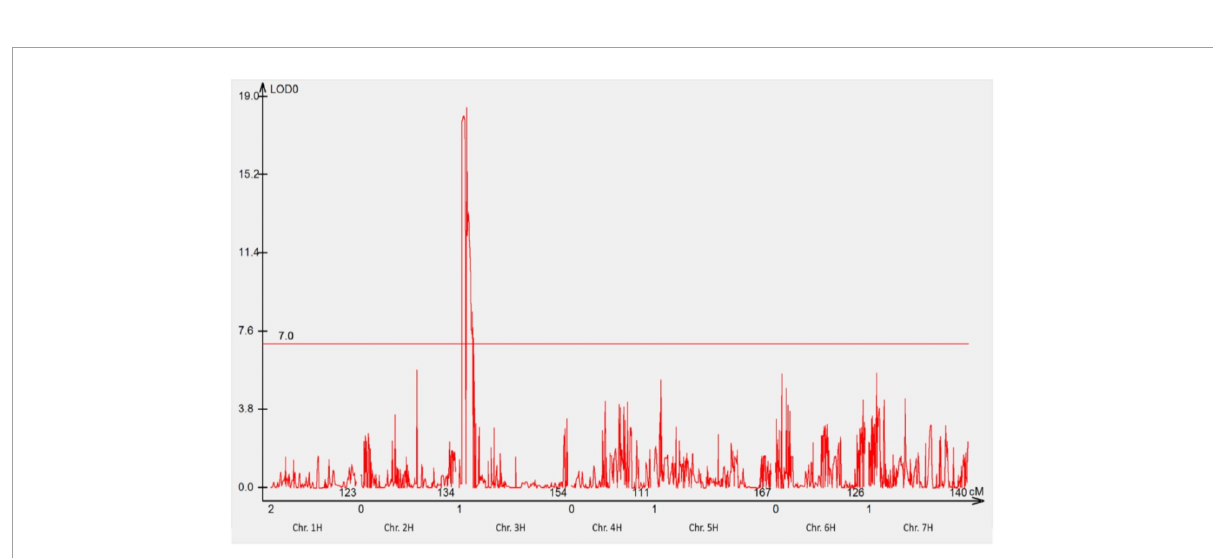
Frontiers in Plant Science